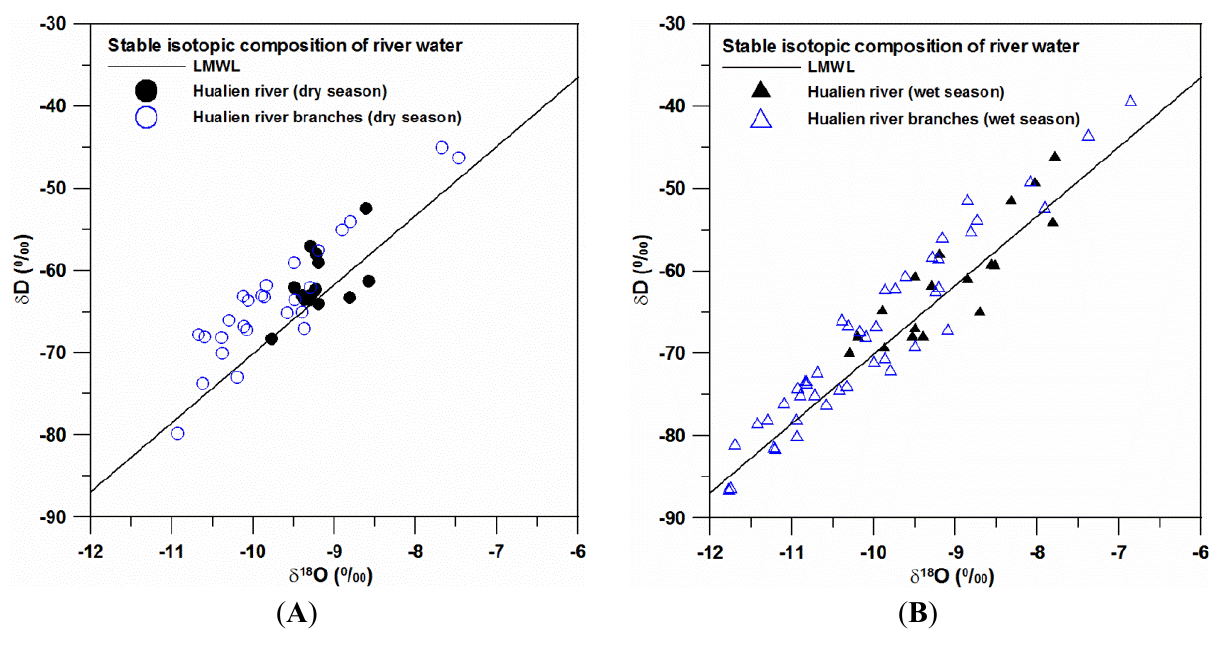
Figure 4. Relationship between δ D and δ 18 O for river water in comparison to the main stream and tributaries of the Hualian River during dry and wet seasons. ( A ) Dry seasons; ( B ) Wet